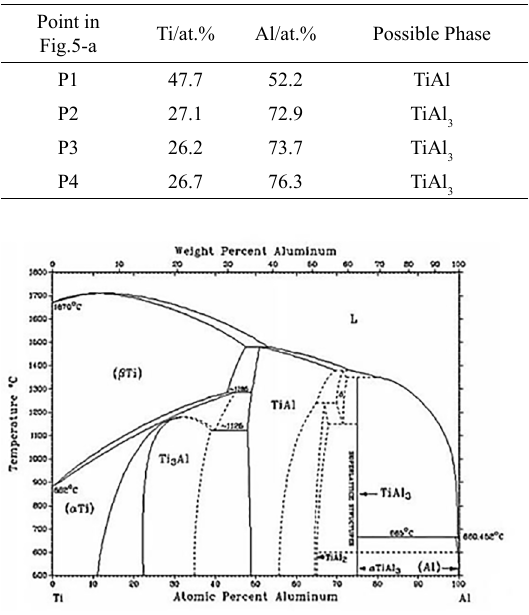
Figure 9. Ti-Al binary phase diagram 22